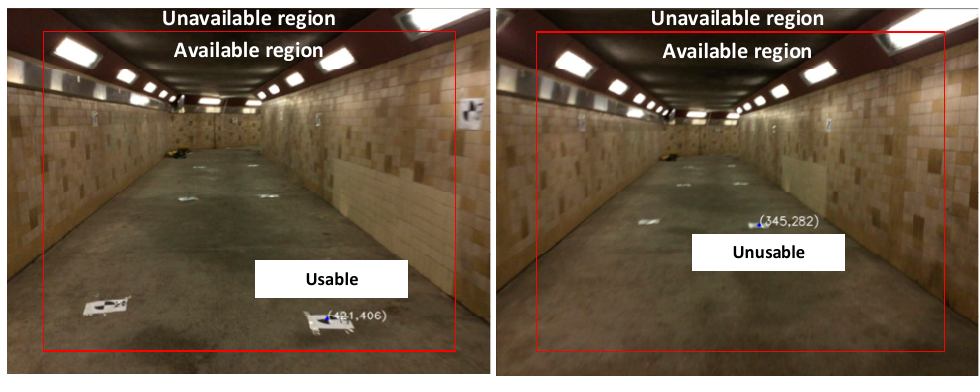
Figure 7. Ground truth obtained from total station.